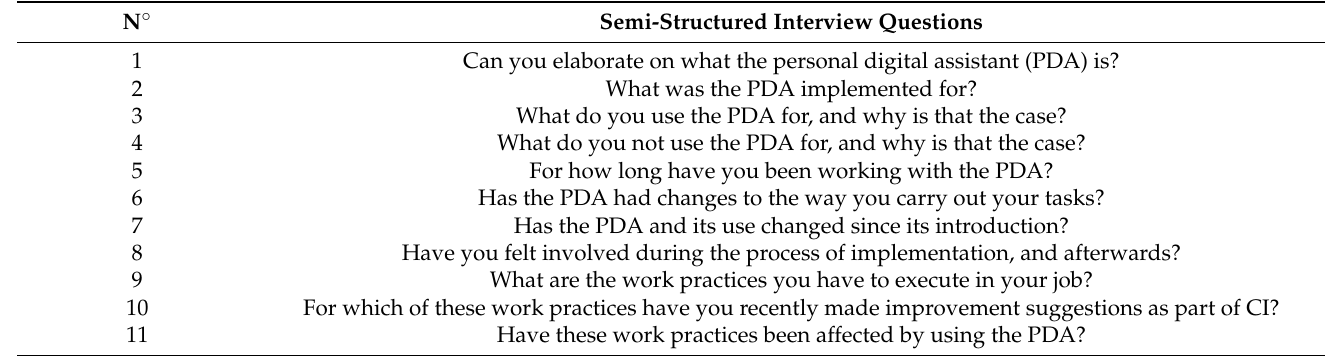
Table A2. Semi-structured interview questionnaire.